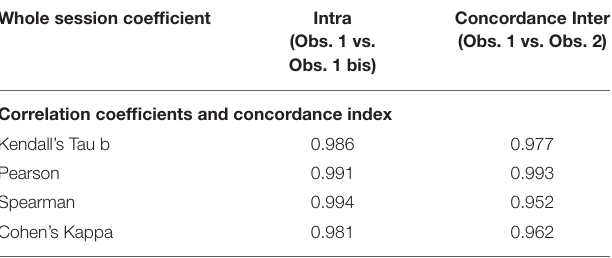
TABLE 3 | Values of Kendall’s, Pearson’s, and Spearman’s Tau b correlation coefficients.